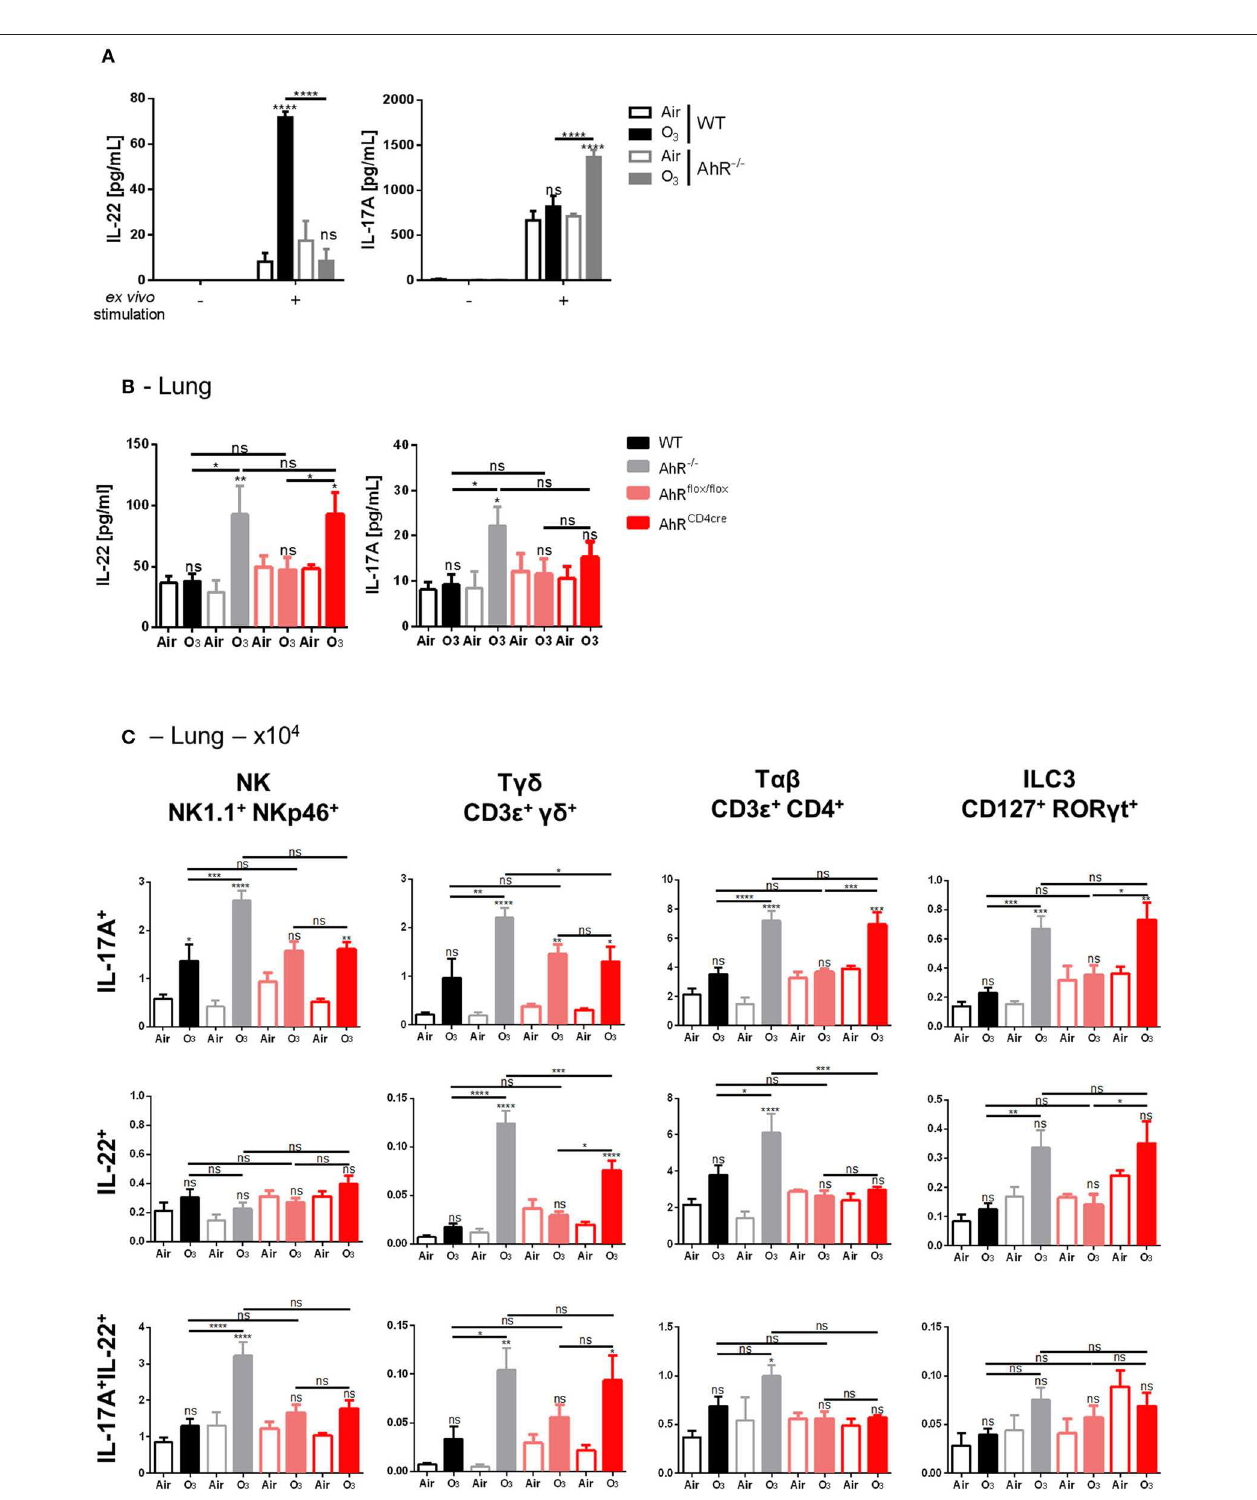
FIGURE 4 | Influence of AhR on IL-17A and IL-22 production. IL-22 and IL-17A release after ex vivo stimulation of lung cells (A) . Levels of IL-17A and IL-22 in WT and AhR deficient mice (B) . Absolute number (C) of NK (NK1.1 + NKp46 + ), ILC3 (CD45 + Lin − CD127 + Ror γ t + ), αβ T cells (CD45 + CD3 ε + CD4 + ), γδ T cells (CD3 ε + pan γδ + ), IL-17A + , IL-22 + , and IL-17A + IL-22 + producing cells. The data are representative for one of independent experiments with n = 5–6 mice per group. Values are expressed as mean ± SEM. Statistical significance was defined at a p -value **** < 0.0001, *** < 0.001, ** < 0.01, and * < 0.05.